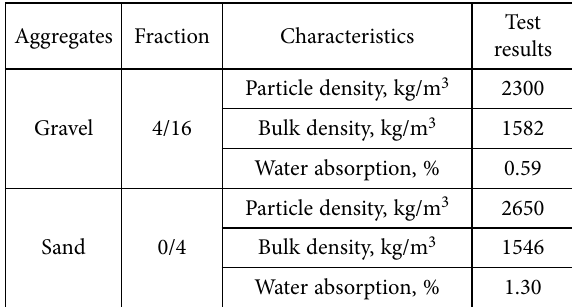
Table 2. Physical properties of gravel and